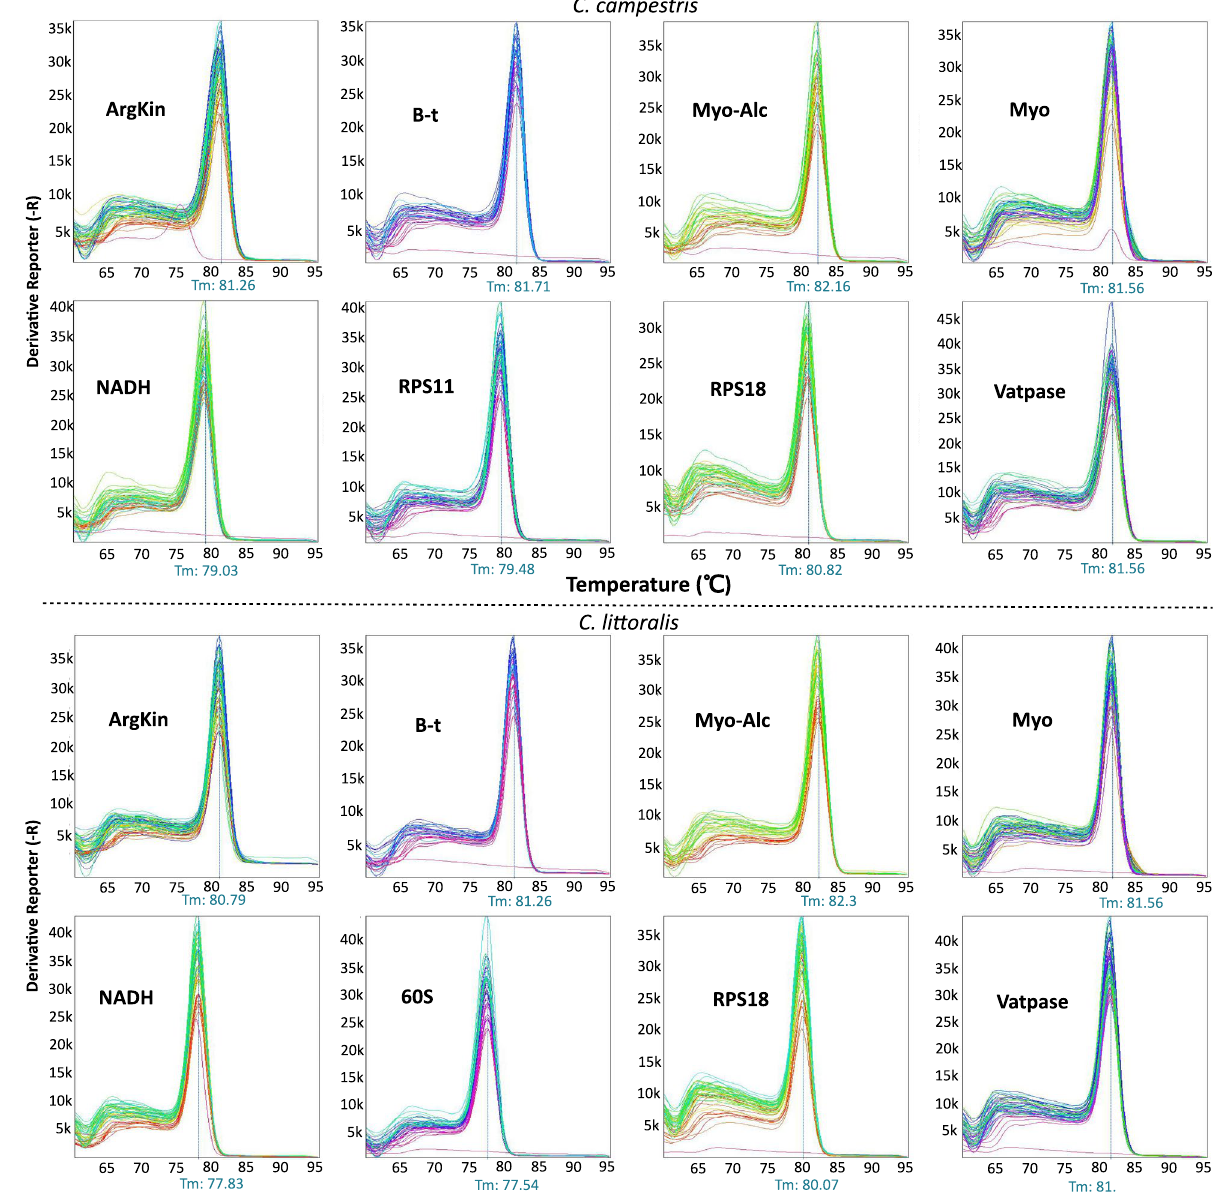
Figure 3. Melt curves for each gene and species studied. Each graph represents all the curves for all conditions tested for that gene. Peaks indicate the melt temperature for each fragment amplified, showing single peaks with no dimer primer or contamination peak